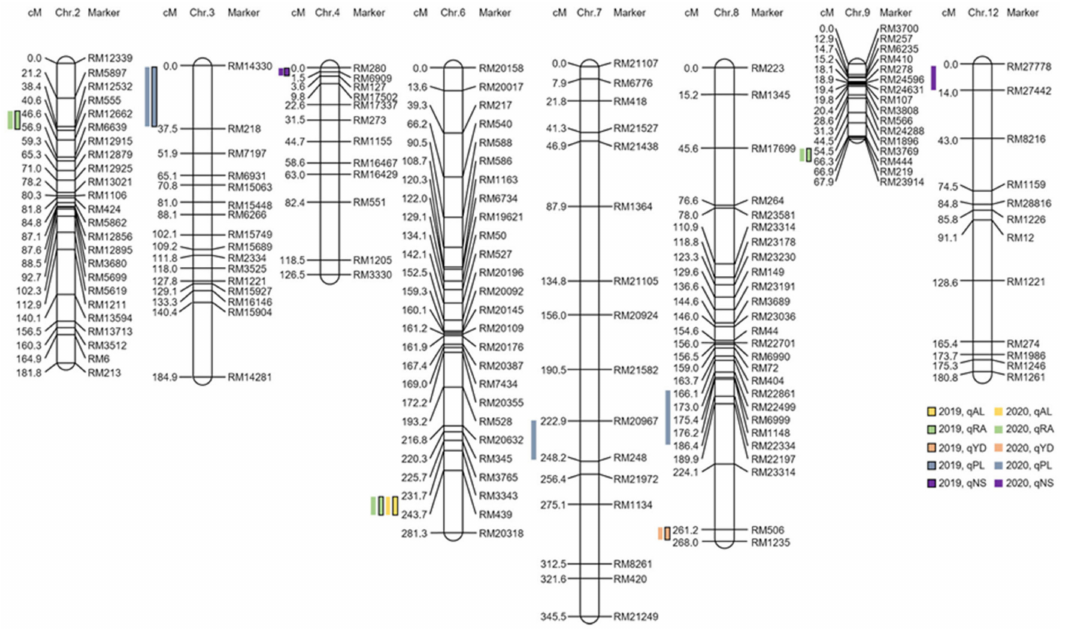
Figure 3. Chromosomal location of the QTLs associated with awn development. QTL mapping results indicate that awn development and elongation-related genes are located on chromosomes 2 to 4, 6 to 9, and 12. Among the detected QTLs, RM12662-RM6639 on chromosome 2, RM14330-RM218 on chromosome 3, RM280-RM6909 on chromosome 4, RM3343-RM439 on chromosome 6, RM506- RM1235 on chromosome 8, and RM3769-RM444 on chromosome 9 were detected in regions with an LOD score of 3.0 or higher for two consecutive